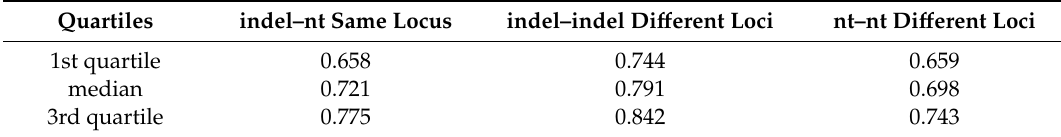
Table 3. Robinson–Foulds (RF) distances.